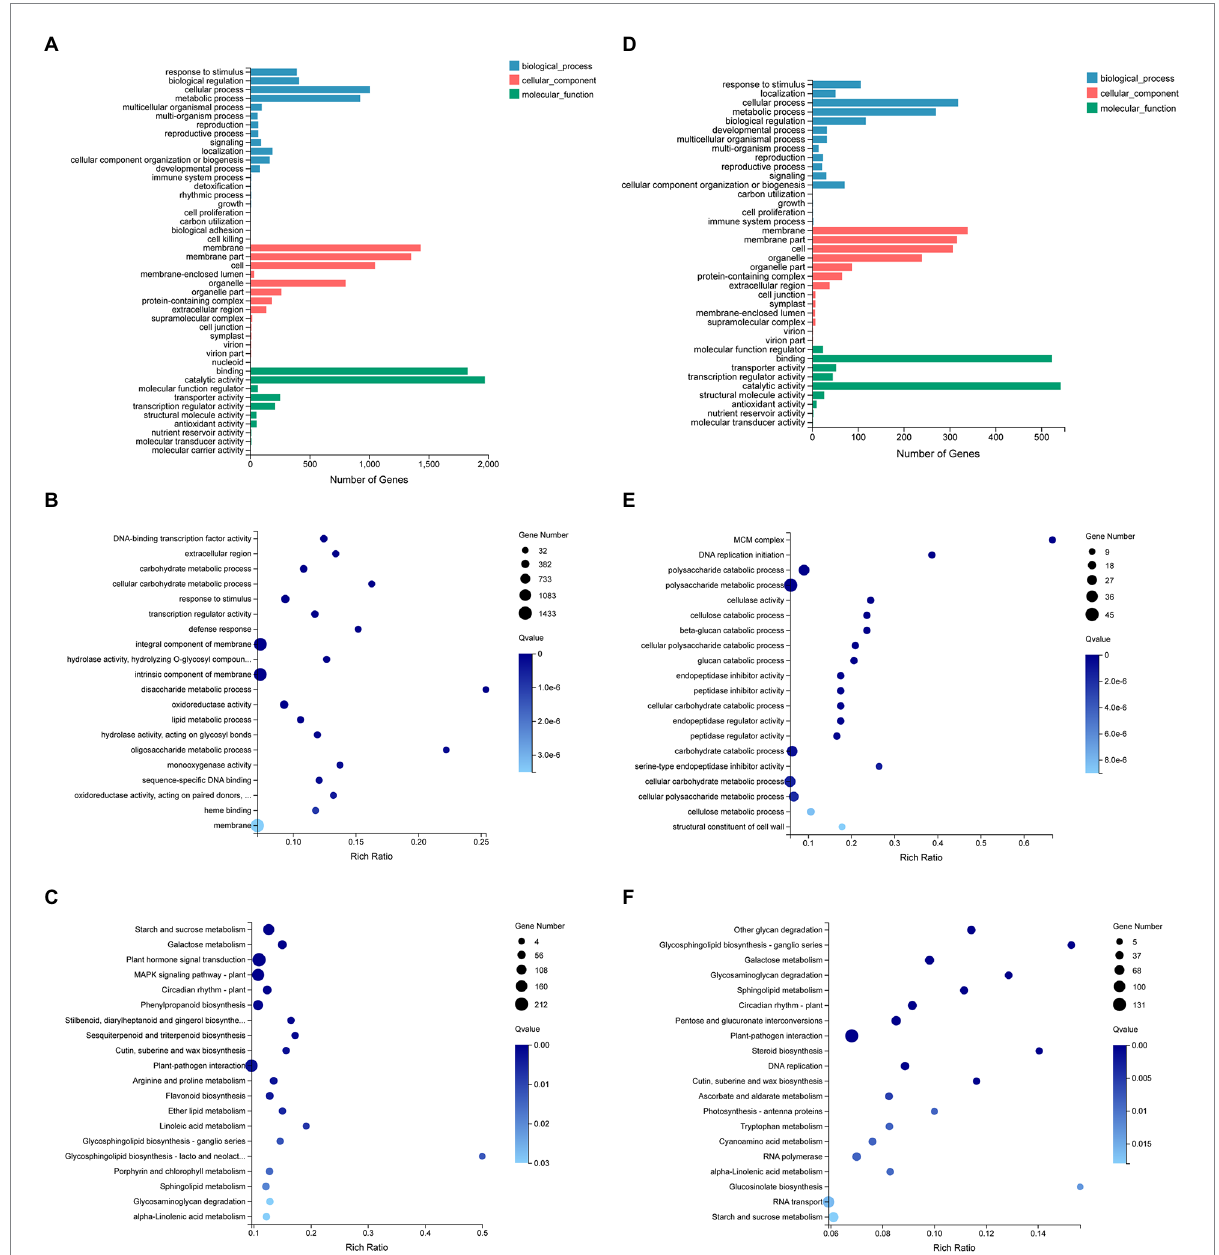
FIGURE 5 GO analysis and KEGG Pathway of transcriptome differential genes in N vs. N-TMV group and N-TMV vs. WT-TMV group. Go classification of differential genes (A) , Bubble plot of GO enrichment of different genes (B) and Bubble plot of KEGG Pathway enrichment of different genes (C) in N vs. N-TMV group. Go classification of differential genes (D) , Bubble plot of GO enrichment of different genes (E) and Bubble plot of KEGG Pathway enrichment of different genes (F) in N-TMV vs. WT-TMV